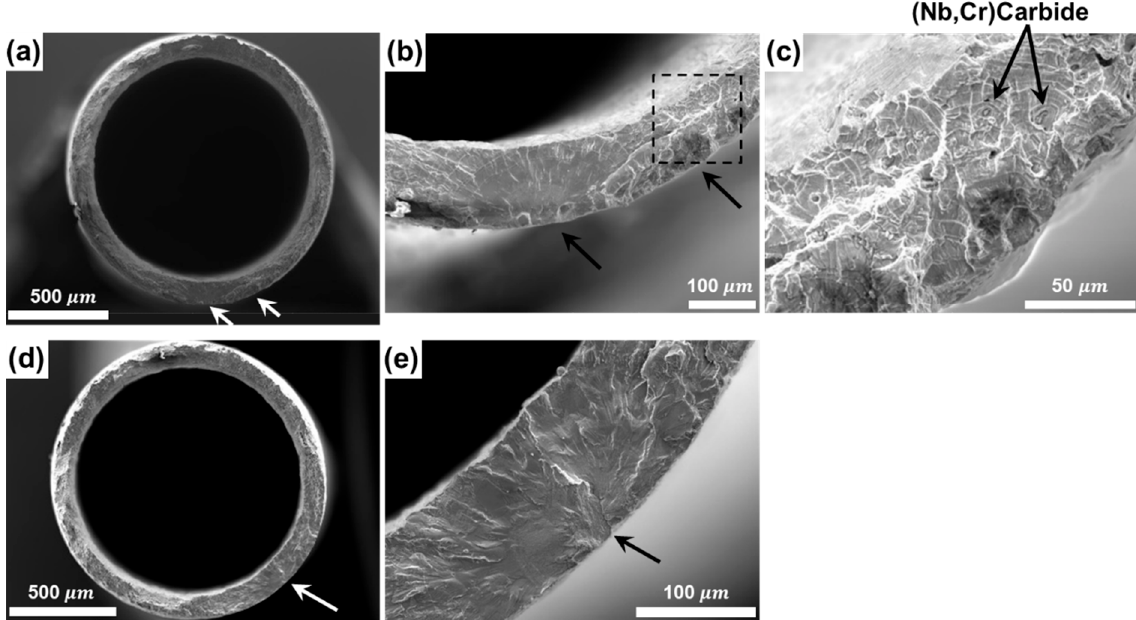
Figure 11. Fracture surfaces for ( a – c ) short-life (78,621 cycles) and ( d , e ) long-life (781,887 cycles) specimens tested at 1000 K and σ max = 402 MPa. The arrows in ( a , b , d , e ) indicate the crack initiation sites. ( c ) presents the enlarged image of the area highlighted in ( b